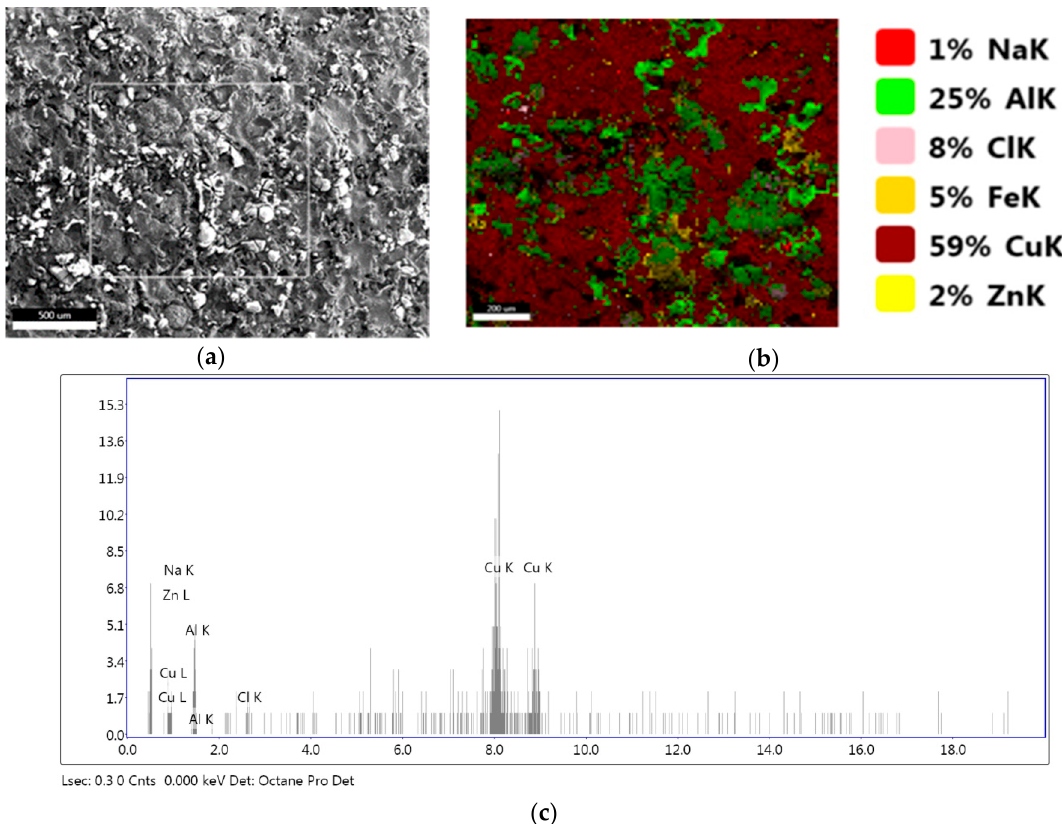
Figure 11. SEM morphology, energy dispersion spectroscopy, and elementary mapping of the aluminum–bronze film after the Tafel tests for the coating, 69 kPa C 2 H 6 –359 kPa O 2 .